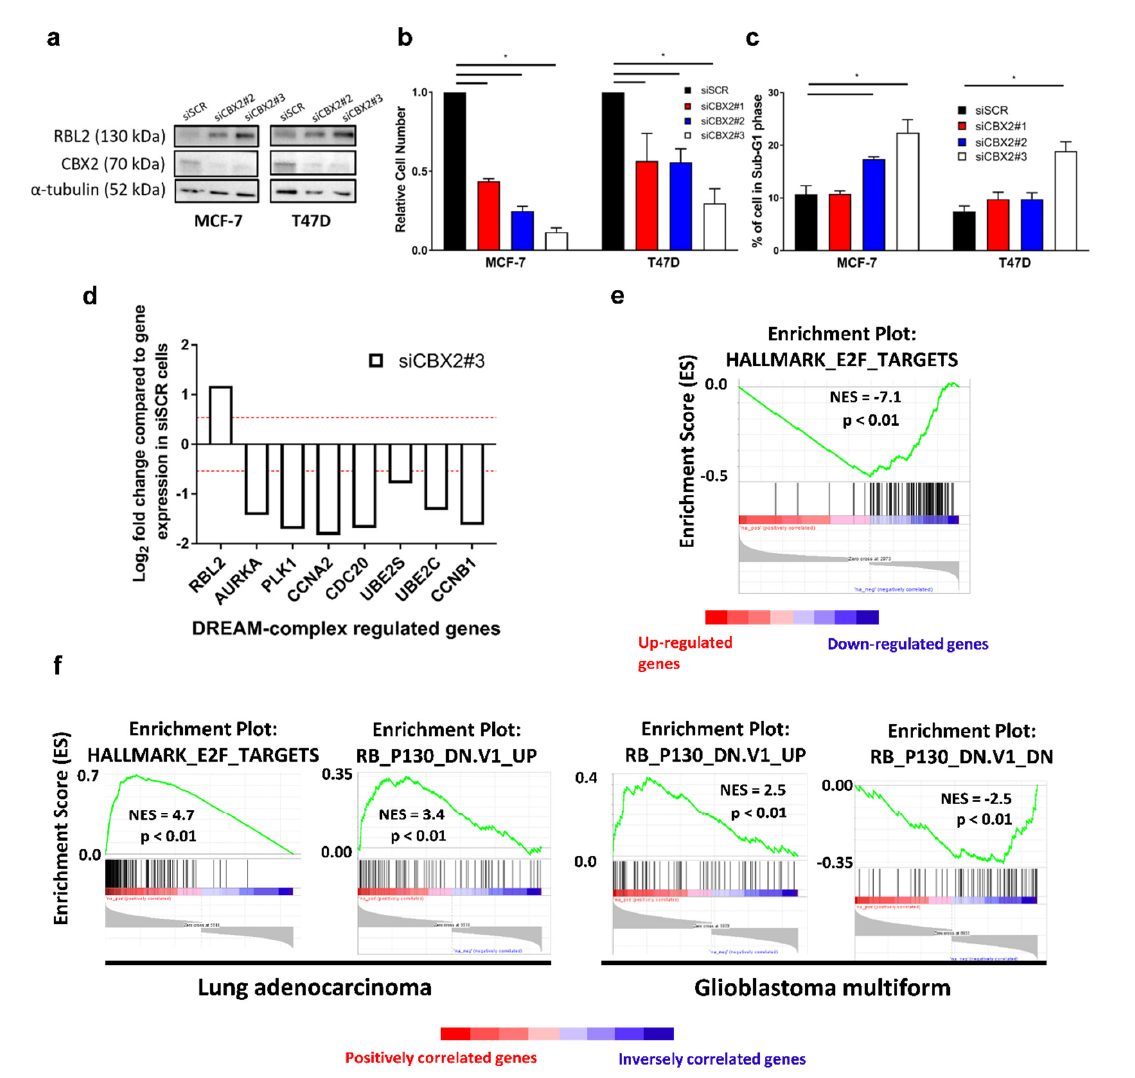
Figure 4.– CBX2 is associated with DREAM complex activity in other cancer types . MCF ‐ 7 and T47D cells were transfected with either a non ‐ silencing siRNA control (siSCR) or CBX2 targeting siRNAs (siCBX2#1/#2/#3) and grown for 72 h followed by protein expression analysis ( a ), cell growth anal ‐ ysis (b) and cell cycle analysis ( c ). ( a ) CBX2 and RBL2 protein expression was assessed by Western blot. α‐ tubulin protein expression was assessed to compare protein loading between samples. ( b ) Cell growth was assessed by cell counts. Cell count data are the mean of 3 repeats ± SEM and are expressed relative to cell counts for siSCR transfected cells. ( c ) The effect on the cell cycle was as ‐ sessed by propidium iodide flow cytometry. Data show the % of cells in the sub ‐ G1 phase of the cell cycle and are an average of 3 repeats ± SEM. p ‐ values for ( b ) and ( c ) were determined by Turkey’s multiple comparisons test (* denotes p < 0.05). ( d ) RNA ‐ seq analysis of RBL2 ‐ DREAM complex tar ‐ get genes in MCF ‐ 7 cells transfected with siCBX2#3 compared to siSCR transfected cells. Data are presented as log 2 fold change in expression. The red line represents a 1.5 ‐ fold increase or decrease in expression compared to siSCR transfected cells. All genes are significantly differentially ex ‐ pressed (padj < 0.05). ( e ) GSEA of the CBX2 ‐ regulated transcriptome (defined as genes significantly (padj < 0.05) up ( n = 2973) or down ( n = 2011) regulated 1.5 ‐ fold after knockdown compared to siSCR controls) against the “Hallmark” curated data sets identified significant negative enrichment of genes associated with HALLMARK_E2F_TARGETS. NES = normalised enrichment score. P = nom ‐ inal p ‐ value. ( f ) GSEA of genes significantly positively and inversely correlated (Spearman’s p < 0.05) with CBX2 expression from TCGA PanCancer Database for Lung Adenocarcinoma and GBM. NES = normalised enrichment score. p = nominal p ‐